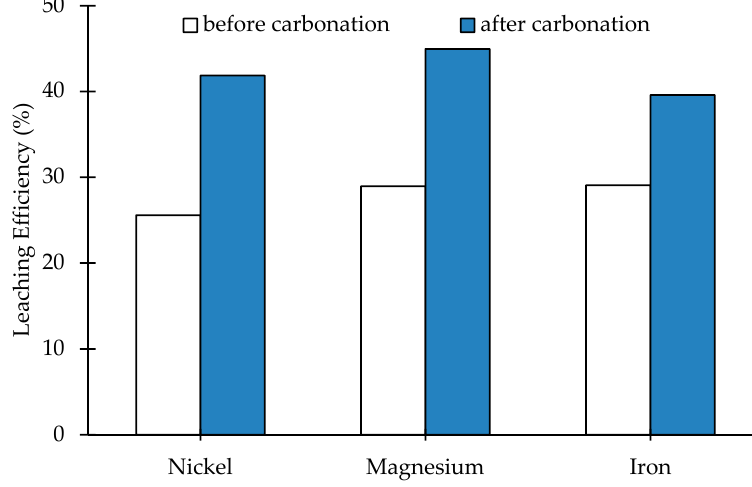
Figure 13. Leaching efficiency of iron from a carbonated olivine depending on concentration of hydrochloric acid and temperature for the fraction 20–63 µm.